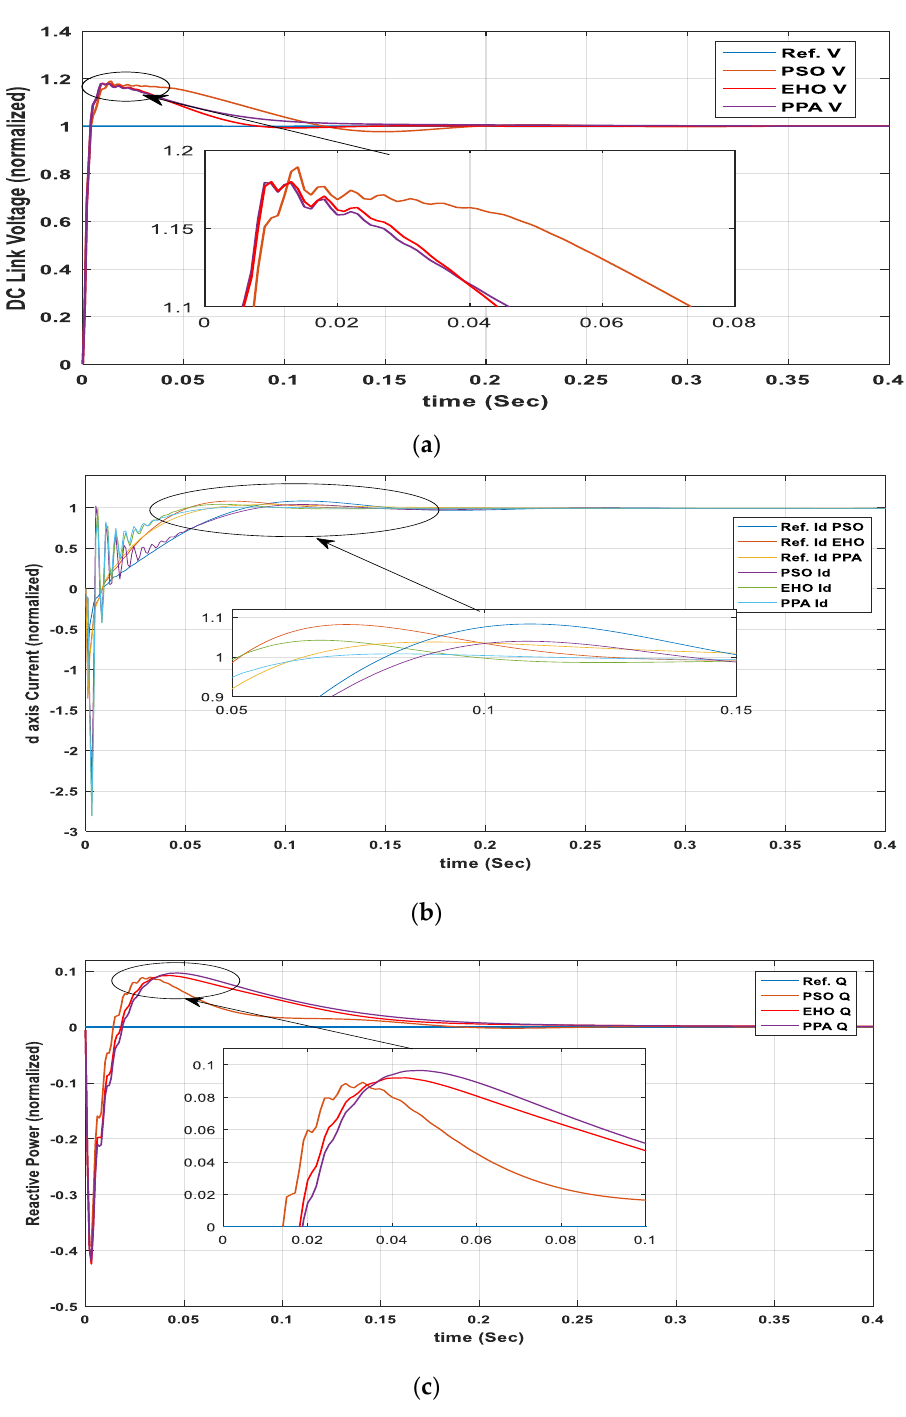
Figure 11. Controller time response. ( a ) DC link voltage controller; ( b ) d-axis current controller; ( c ) q-axis current/reactive power controller.